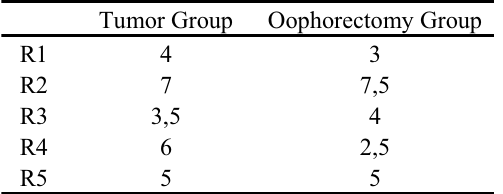
TABLE 2 - Volume of tumor mass extracted from female rats